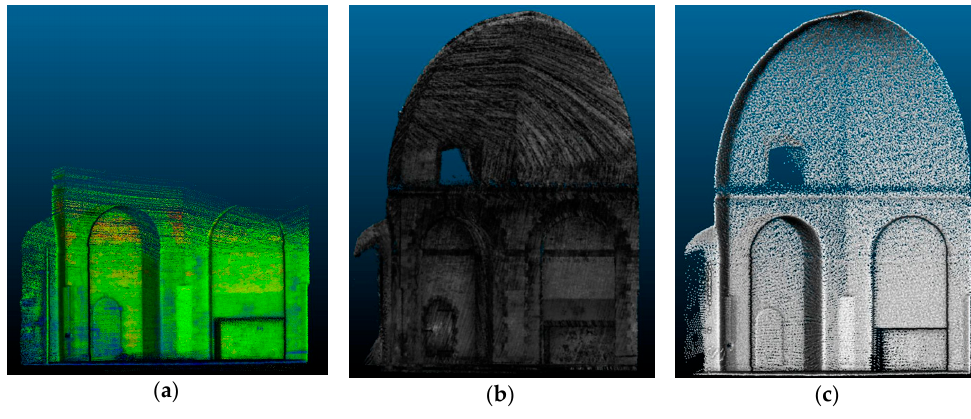
Figure 22. Octagonal room—data visualization assessment; ( a ) Stencil; ( b ) Pegasus; ( c ) Zeb-Revo. The comparison was done with the C2M tool in CloudCompare on the datasets acquired in path 1 and the results are shown in Figure 23. The Stencil and Zeb-Revo essentially confirm the general results displayed in Figures 7a and 15a. Here they are more detailed with a histogram of the signed distances: in both cases, the data are distributed around a slightly different value from zero, but they are essentially symmetrical. Here the Pegasus dataset instead produced a trimodal distribution of differences, one prevalently coloured in blue (negative values), one in green (values around zero), and one in yellow-orange (positive values). These colours hence represent the prevalent distance from the reference, whose modes are respectively − 8, − 1, and +7 cm: the first two correspond to two “surfaces”, parallel to a real wall facade, as visible in the slice in Figure 24. Note how these two clouds are not clearly recognizable in the frontal representation of Figure 23, where a green coloration is instead dominant. Conversely, the point error on the other, orthogonal façade is represented in a yellow-orange colour.